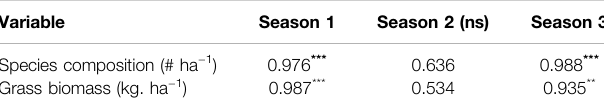
TABLE 5| Correlation analyses( n (cid:2) 5 )ofrelations betweenseason,grassspecies composition and biomass